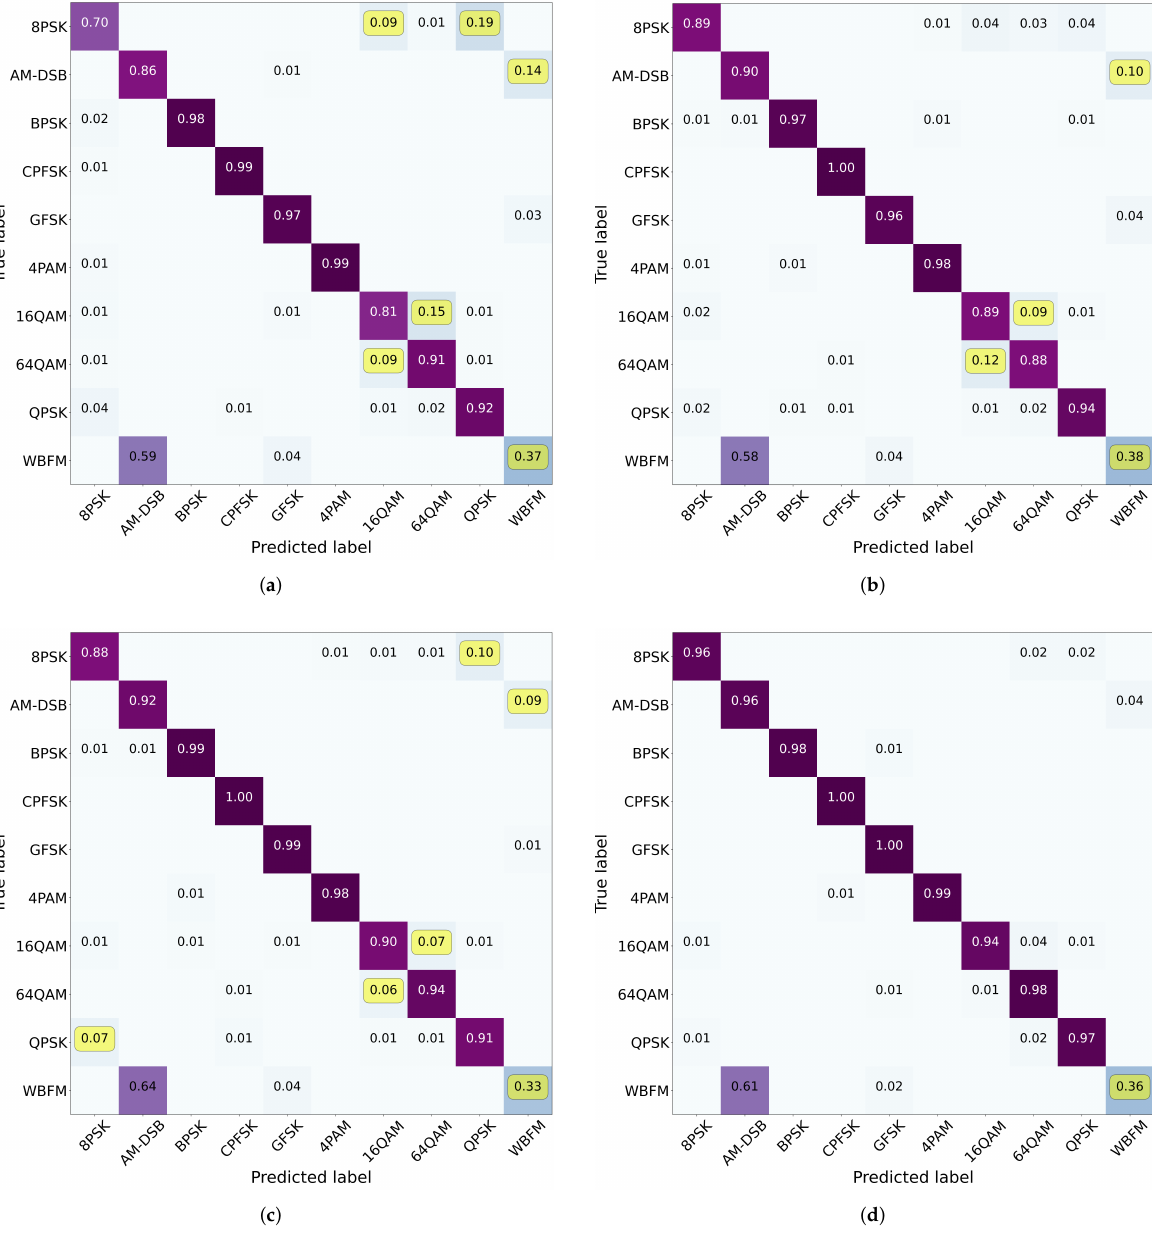
Figure 8. Confusion matrix for ( a ) DAE, ( b ) LENet-T, ( c ) LSTM2, and ( d ) LENet-M at 0 dB on the 2016A dataset. Values less than 0.01 are not included. In the confusion matrix, values above 0.5 are indicated in purple; the darker the value, the greater the confusion. The higher the ambiguity, the darker the value. Yellow represents values between 0.05 and